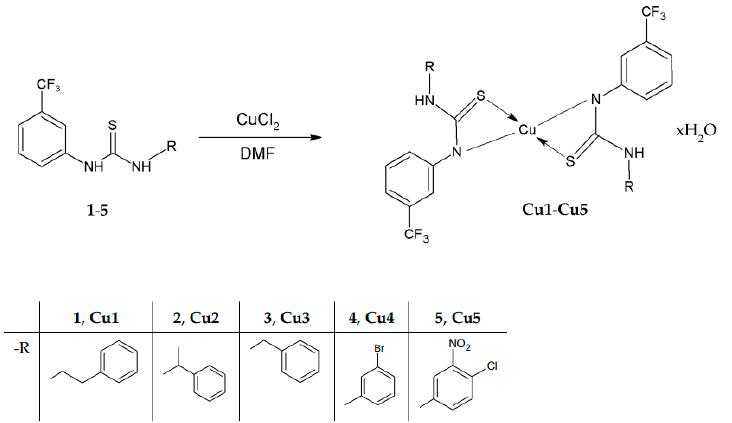
Figure 1. Synthesis path of Cu1 – Cu5 complexes with the following formulas: Cu(1) 2· H 2 O, Cu(2) 2· 0.75H 2 O, Cu(3) 2· 0.5H 2 O, Cu(4) 2· 0.5H 2 O, Cu(5) 2· H 2 O. DMF—dimethylformamide.